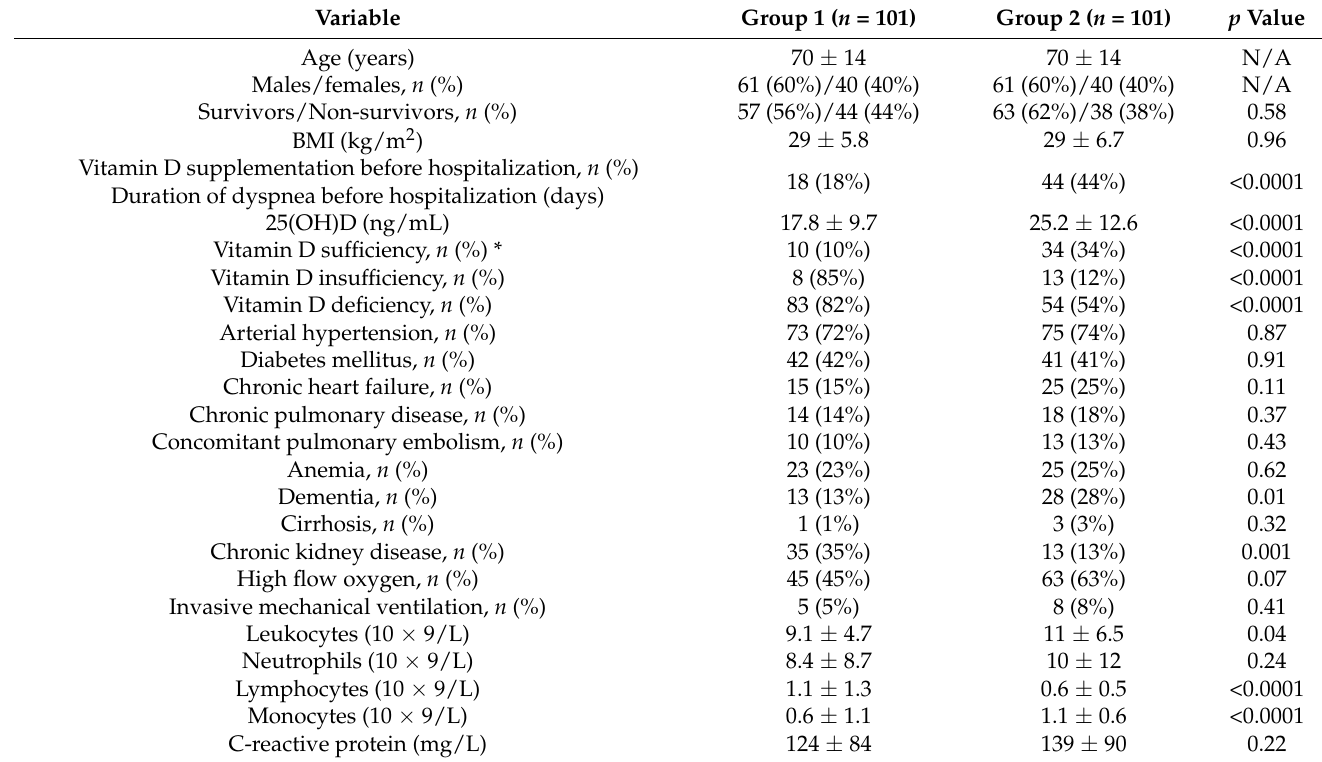
Table 1. Baseline clinical and laboratory characteristics on admission between patients admitted to the hospital in the second wave (2020/21) (Group 1), and patients admitted to the hospital in the third wave (2021/22) (Group 2) of the pandemic. Data are expressed as numbers and percentages or means ± standard